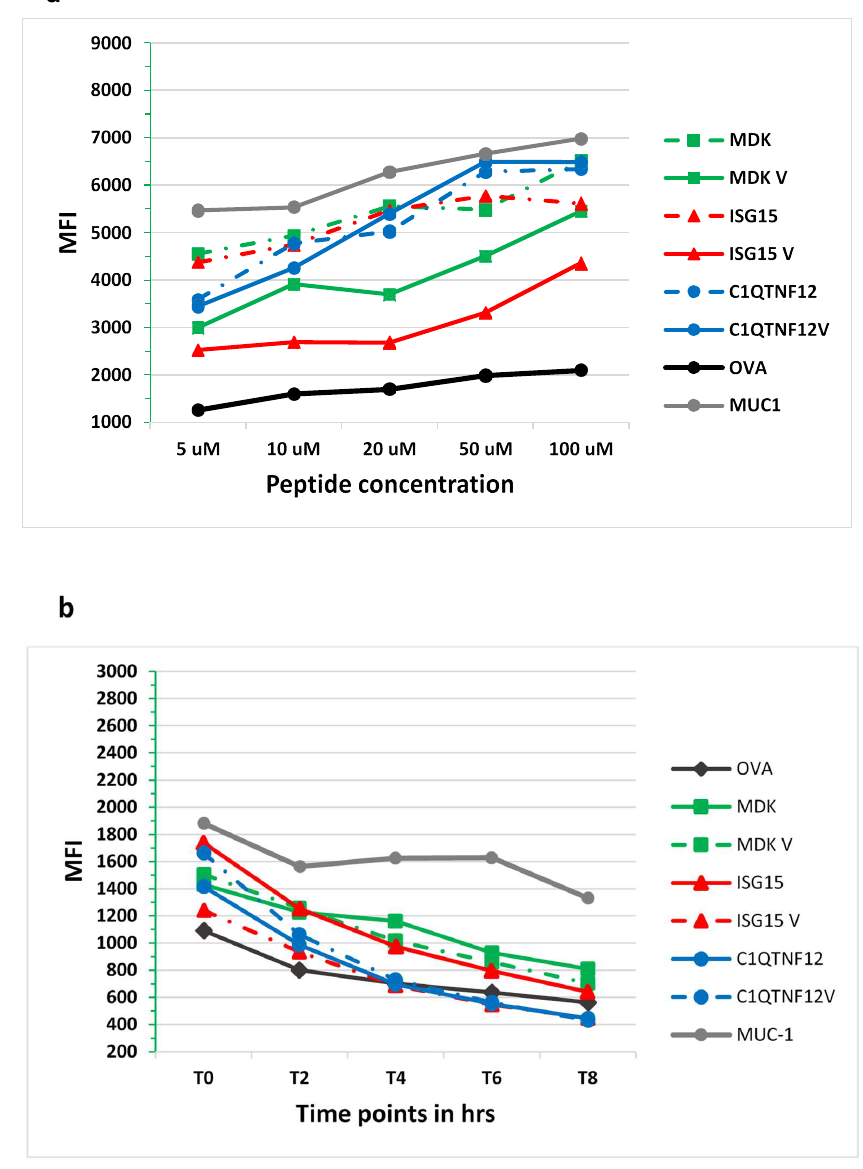
Figure 6. Experimental binding of TAAs and viral paired peptides to HLA-A*0201. Binding to HLA-A*0201 molecule and relative stability was assessed in TAP-deficient T2 cells loaded with the indicated peptides: ( a ) mean fluorescence intensity at flow cytometer indicates binding levels of peptides to HLA molecules; ( b ) decay of mean fluorescence intensity over time indicates stability of the peptide binding to the HLA